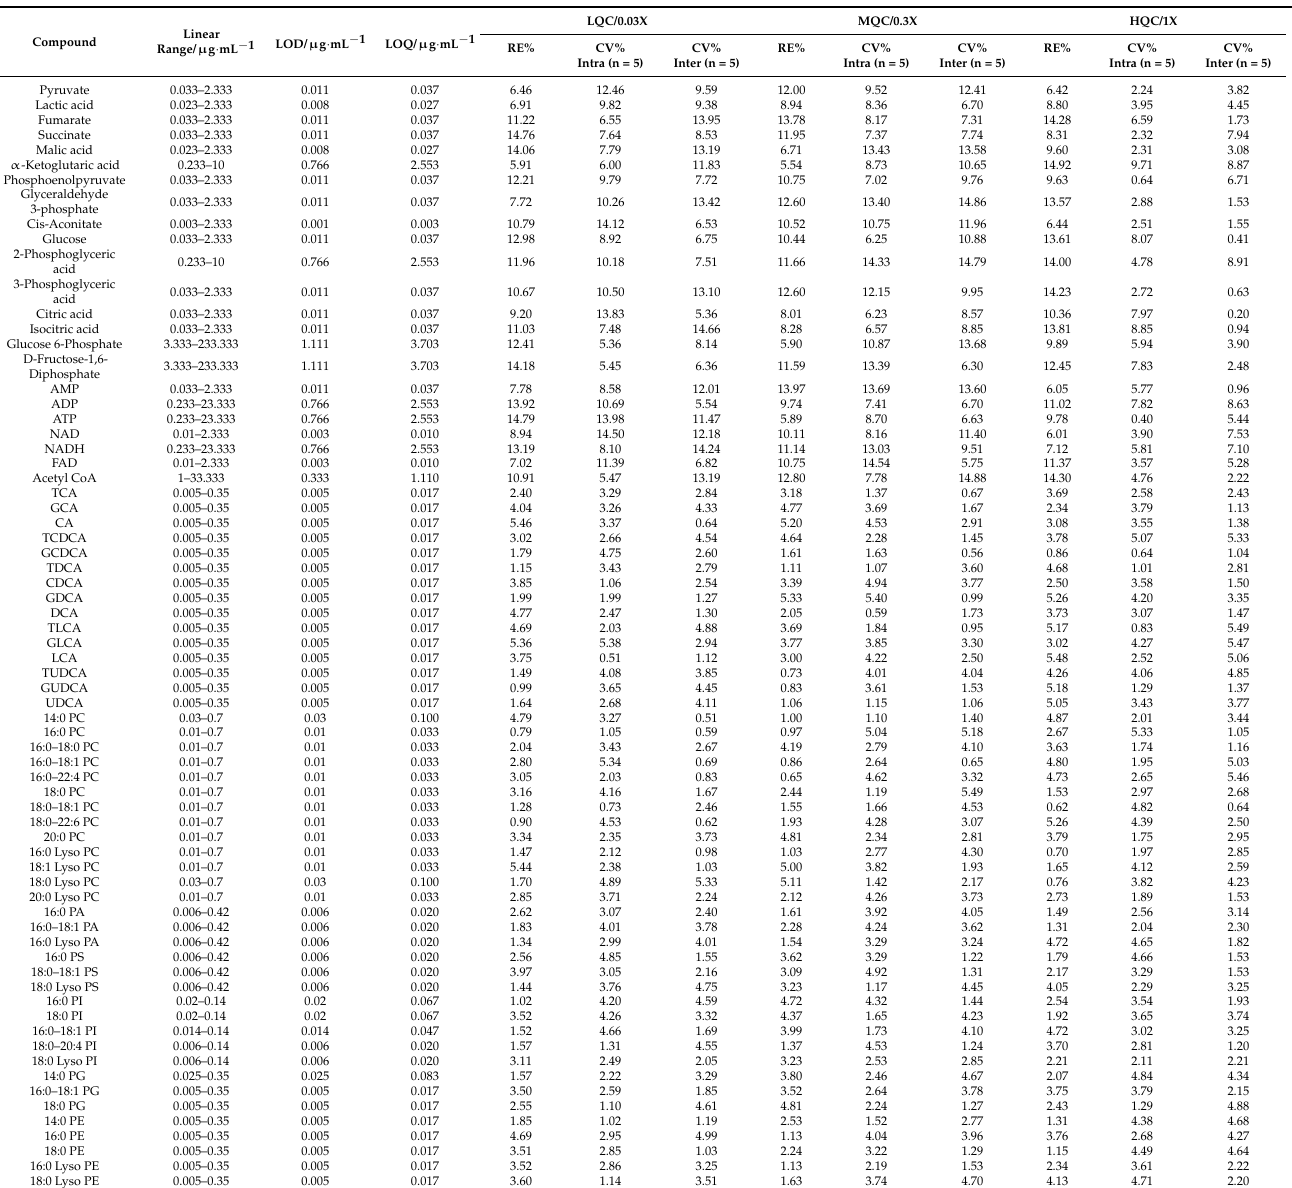
Table 1. Linear range, LOD, LOQ, and precision data of the target compound. Compound